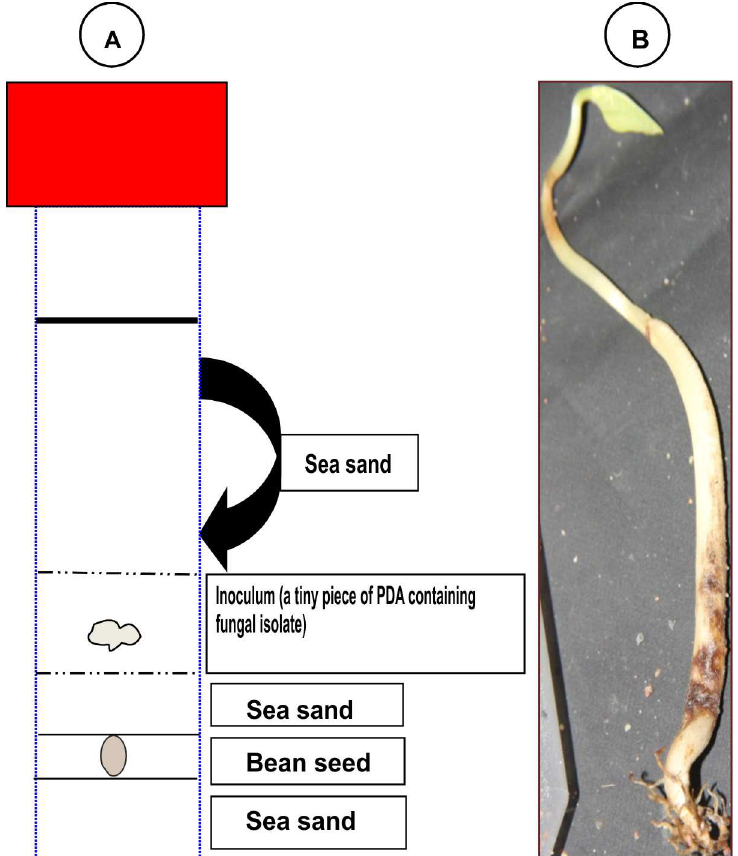
Fig 1. Layout of the pathogenicity test. (a) A pathogen-free pre-germinated lima bean was placed on a layer of sterilized, moist sea sand in a 50-ml sterile test tube. A layer (1 cm) of sand was added, and a piece of PDA containinghyphaeof the fungus was placed on the sand. The tube was filled with sand up to 2 cm from the top, closed loosely with a cap, and incubatedat 20˚C under dim light in a growth room. (b) Seedlings reacheda height of 10–12 cm (unlessheavily damaged) and were observedfor symptoms at 20 dpi. Symptoms shown in (b) were caused by Macrophomina phaseolina